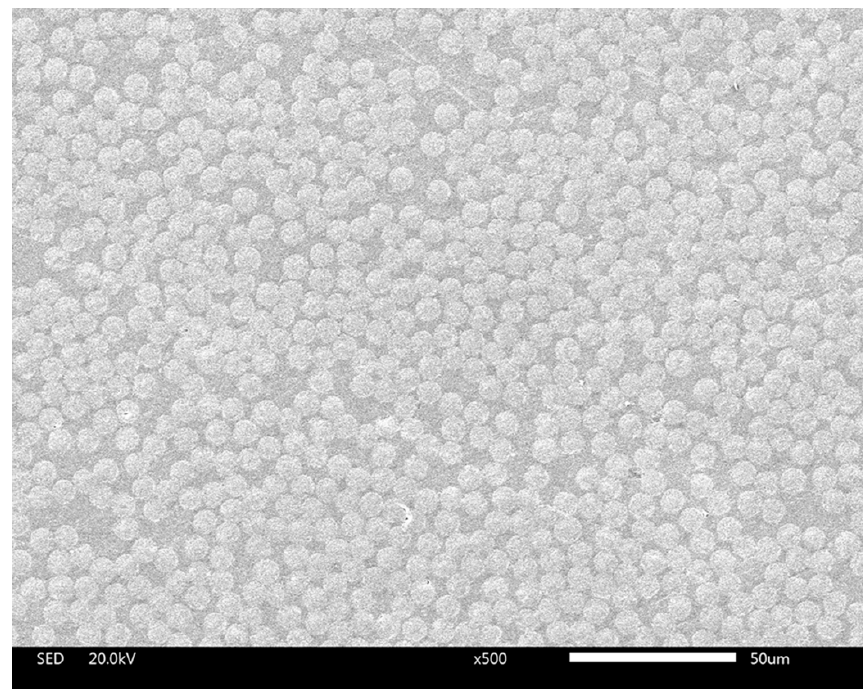
Figure 5. SEM results of the cross section of the transverse plies.